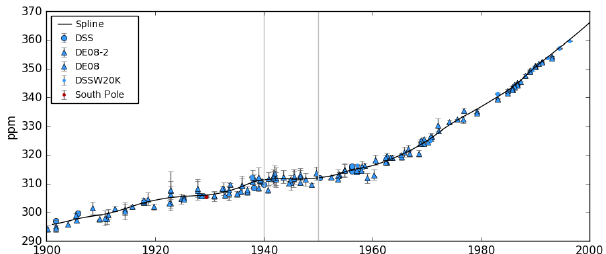
Figure 1. Atmospheric CO 2 concentration in the Law Dome ice core and firn record from Rubino et al. (2013) and respective un- certainties (markers and whiskers) as well as the spline fit applied to the data following Enting et al. (2006), which attenuates by 50% variations of ca. 23 years. The period corresponding to the plateau is highlighted between vertical grey lines. The blue markers cor- respond to samples from Law Dome and red markers from South Pole; different symbols indicate the different ice cores (big mark- ers) and firn samples